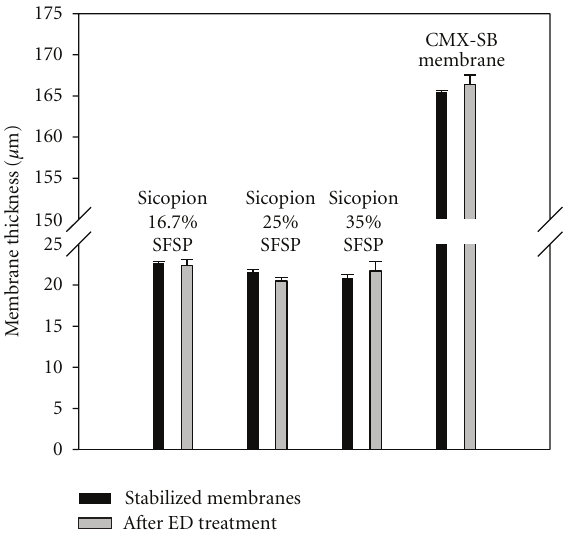
Figure 5: Electrical resistance of conditioned and used (24h after the ED procedure) Sicopion and CMX-SB